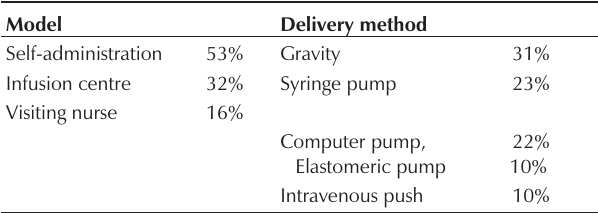
Delivery models used by Outpatient Intravenous Infusion Therapy Association centres